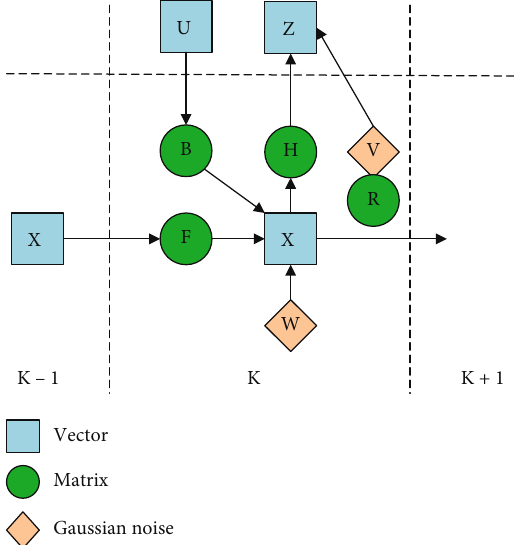
Figure 2: Flow chart of the Kalman denoising algorithm.